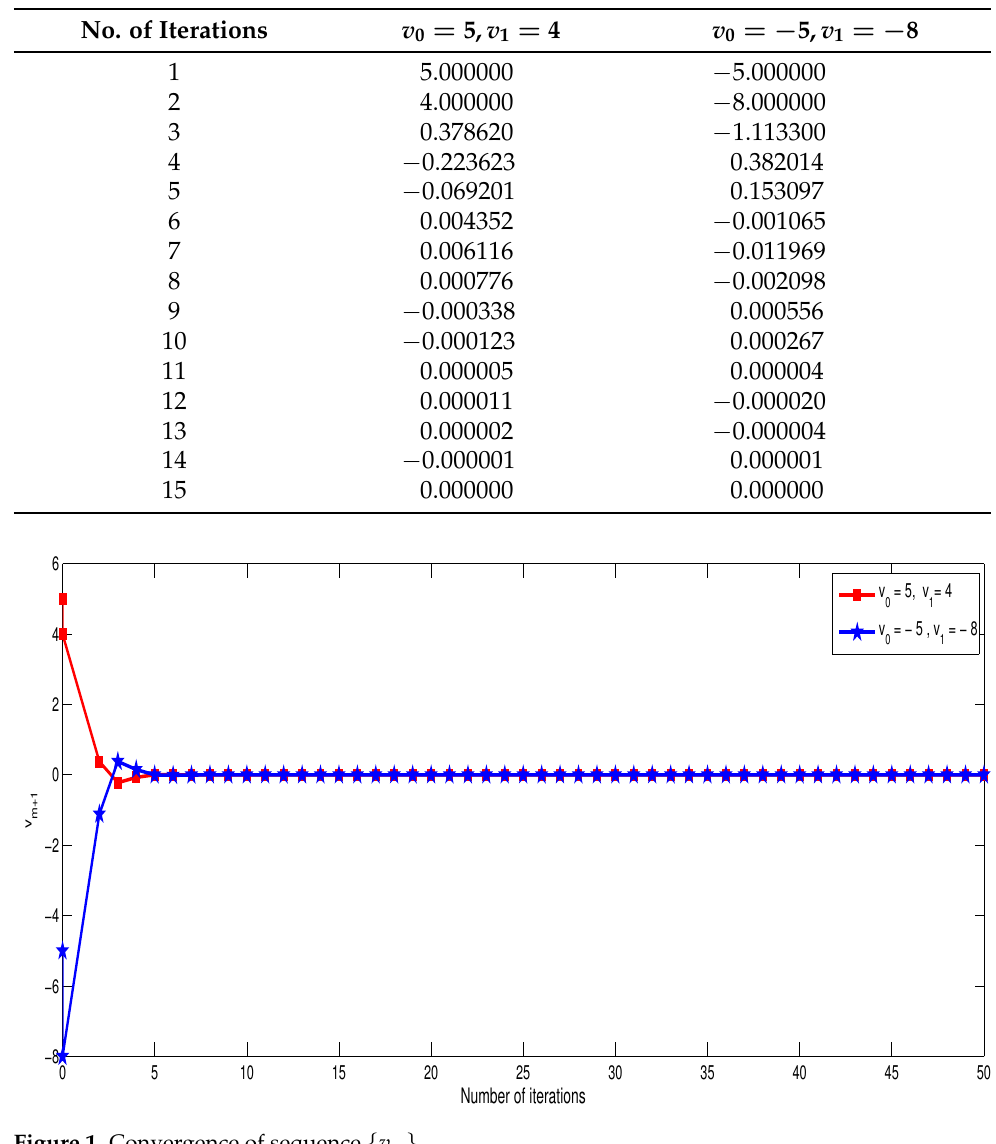
Table 1. Numerical results for different initial values v 0 and v 1 .